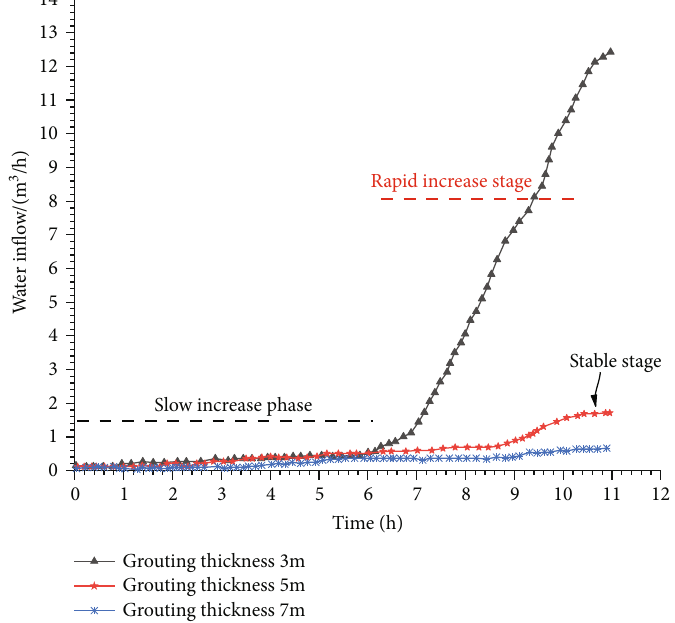
Figure 8: Evolution of water in fl ow in di ff erent grouting thicknesses.